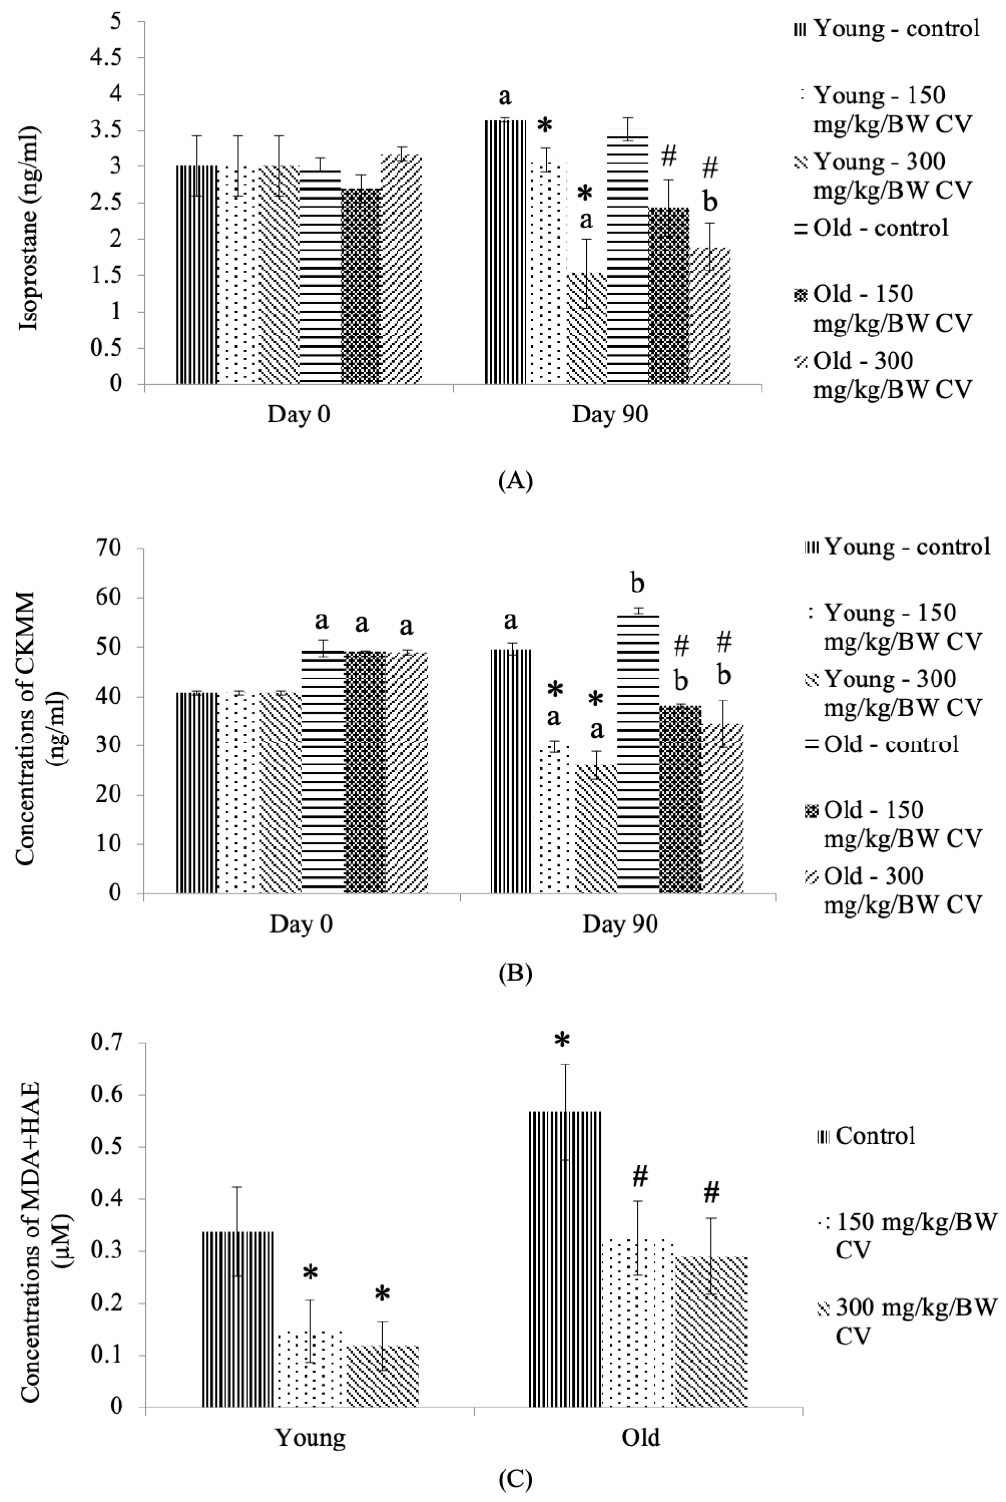
Figure 5. The ( A ) urinary oxidative stress, ( B ) plasma oxidative stress and ( C ) skeletal muscle oxidative stress of young and old rats. Data are presented as the mean ± SD, n = 8 (control rats), n = 10 ( C. vulgaris -treated rats). * p < 0.05 significantly di ff erent compared to the control young rats on Day 90, # p < 0.05 significantly di ff erent compared to the control old rats on Day 90, a p < 0.05 significantly di ff erent compared to the control young rats on Day 0, b p < 0.05 significantly di ff erent compared to the control old rats on Day 0, with a post hoc Tukey HSD test. BW: Body weight; CV: C.